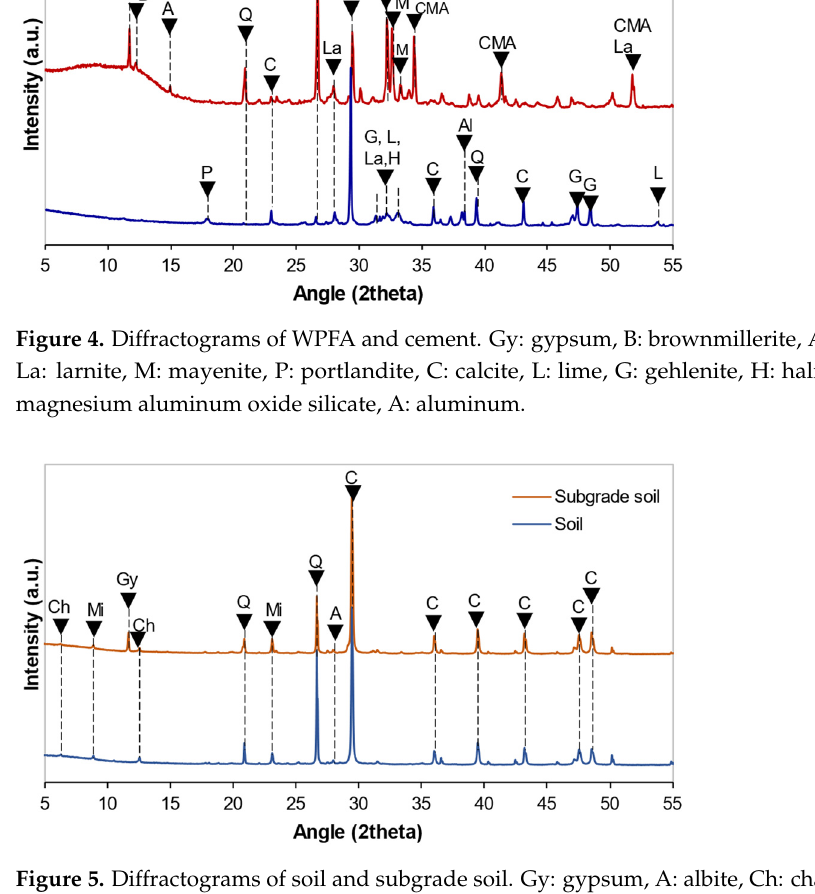
Table 3. Test design parameters for soil stabilization.